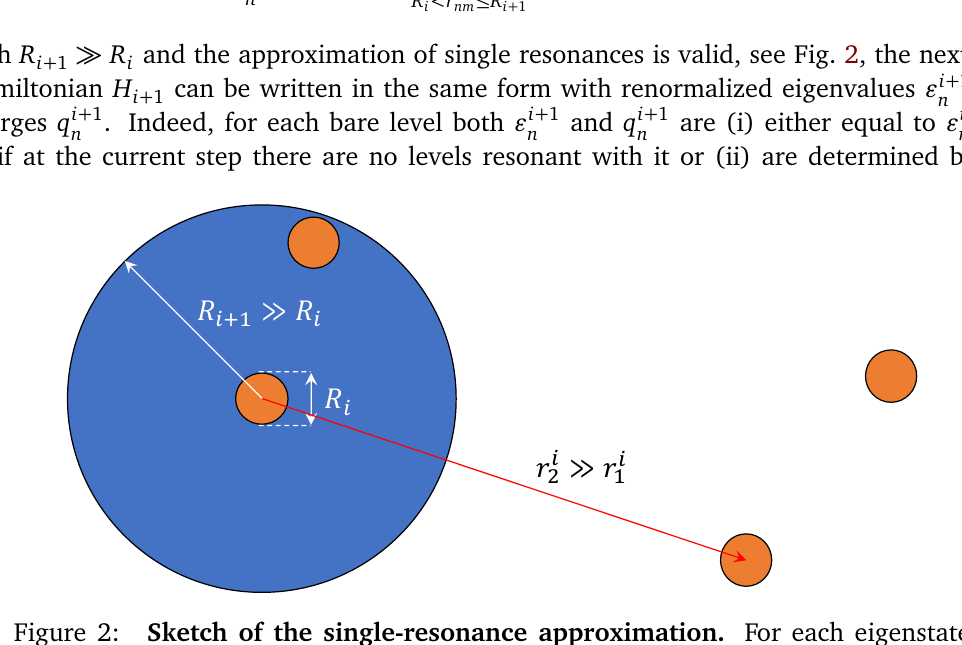
Figure 2: Sketch of the single-resonance approximation. For each eigenstate localized at i th step of RG at the radius R (orange circles) the next cutoff radius i = r i R (blue circle) is determined as the distance to the closest resonant level. i + 1 1 Single-resonant approximation assumes that all other resonant levels are located (cid:29) r i much farther r i 2 1